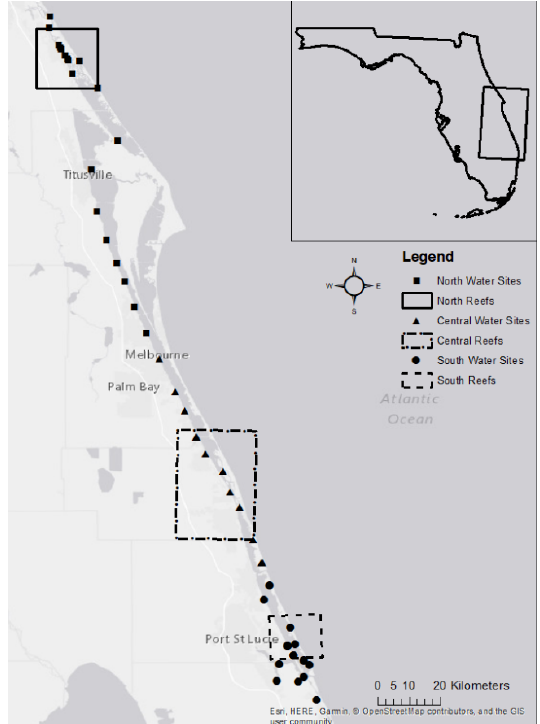
Figure 1. Indian River Lagoon microplastic water sampling sites (points) and oyster reef areas (boxes).